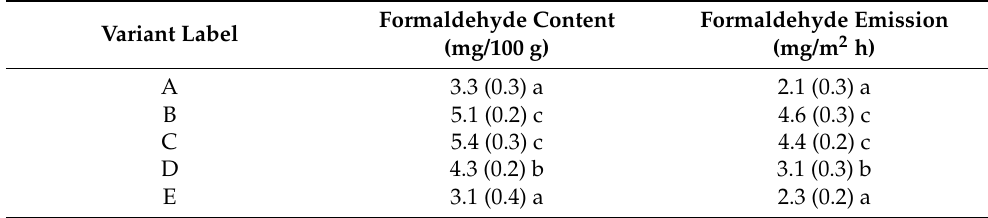
Table 5. Formaldehyde emission and content depending on the variant. Variant